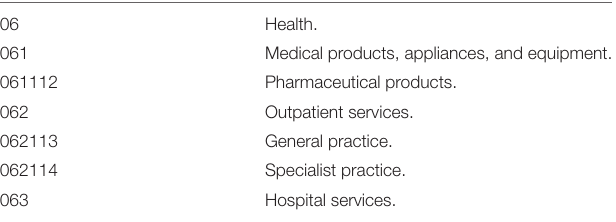
TABLE 1 | Household expenditure categories included in the analysis. 06 Health. Medical products, appliances, and